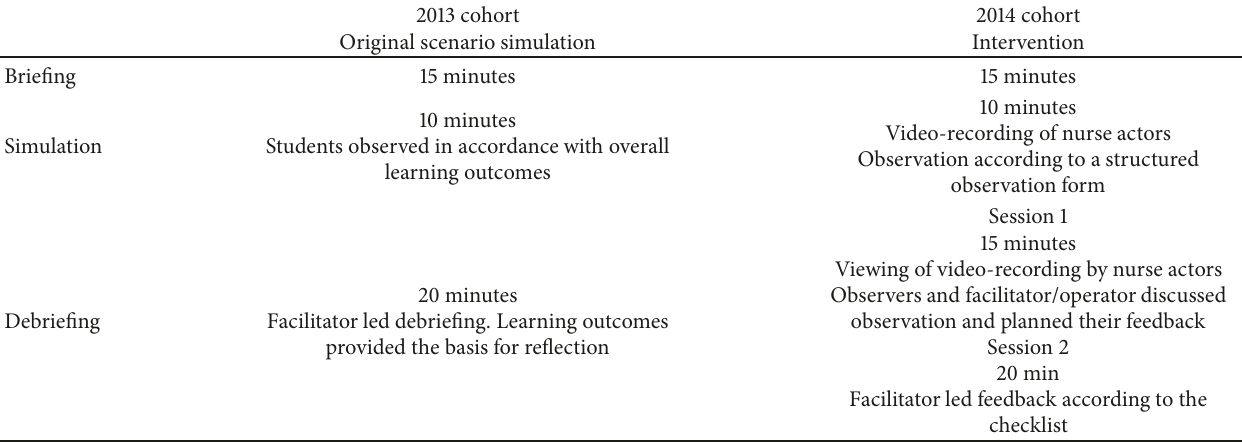
Table 1: Structure of the scenario simulation for both